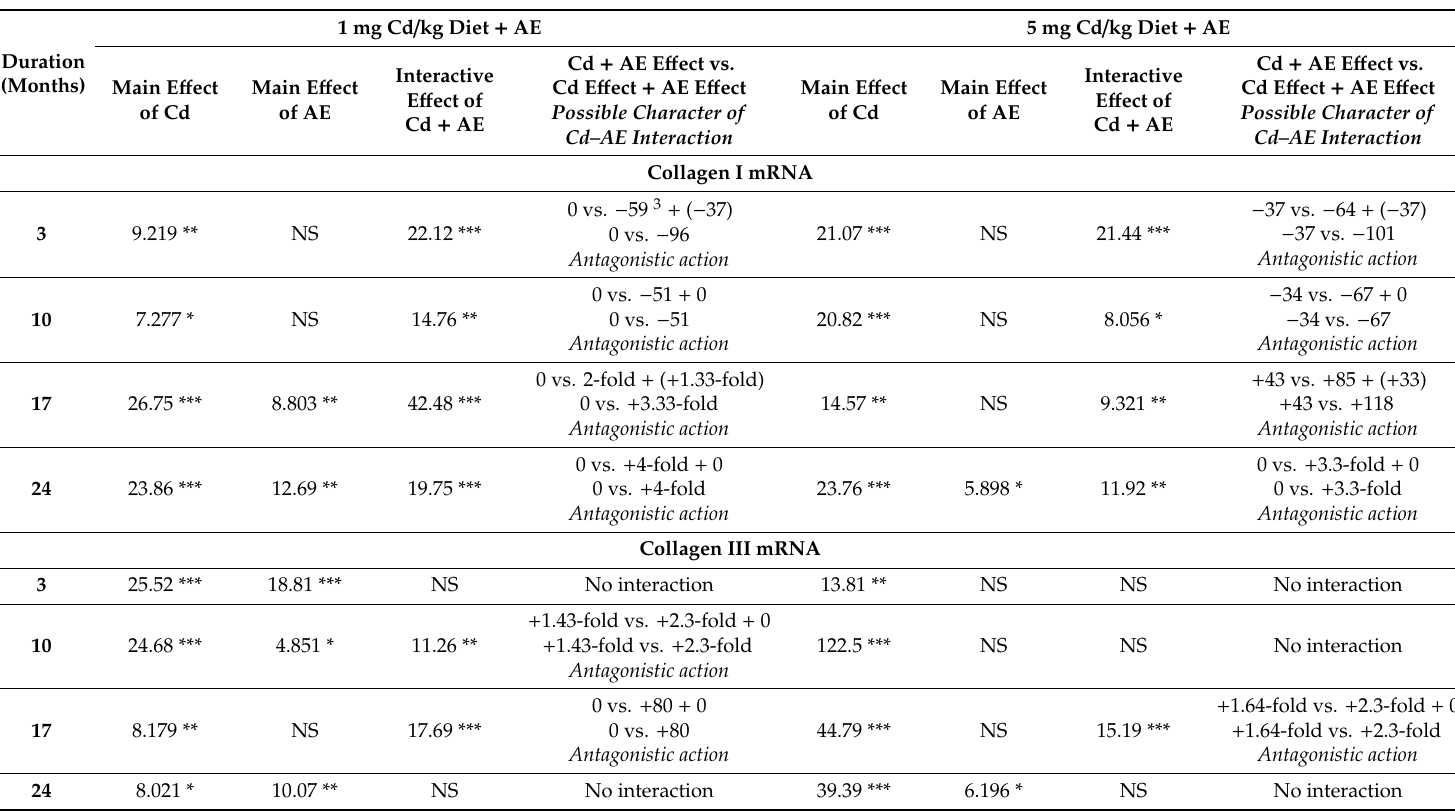
Table 1. Evaluation of the main and interactive e ff ects of cadmium (Cd) and Aronia melanocarpa L. berry extract (AE) on the expression of collagen type I and collagen type III at the messenger ribonucleic acid (mRNA) level in the livers of rats 1,2